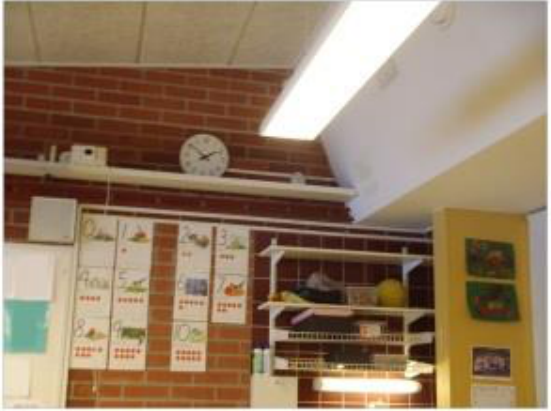
Figure 5 . I would like to learn how to read the time